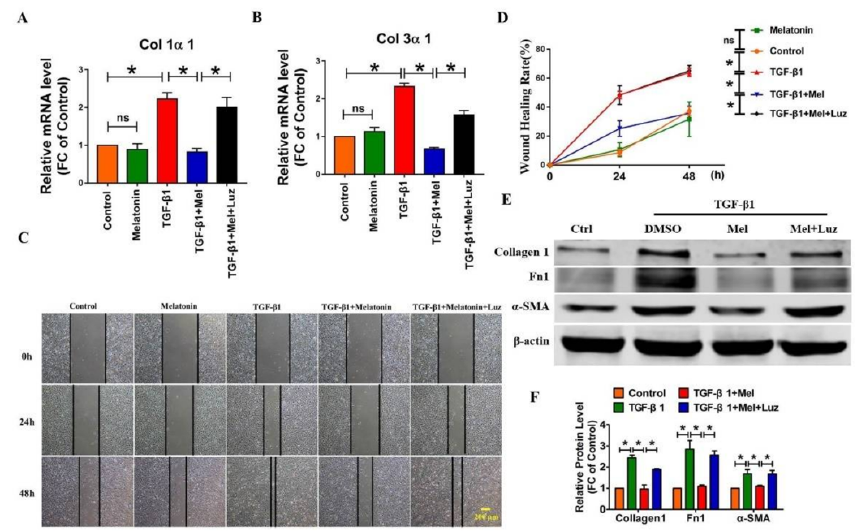
Figure 2. Identification of melatonin receptor as a functional target in melatonin-mediated fibrosis. mRNA expression of Col 1 α 1 ( A ) and Col 3 α 1 ( B ) was obtained with qRT-PCR. β -Actin was used as the internal control. ( C , D ) Wound healing assay demonstrated that luzindole abolished the TGF- β 1-induced cell migration and the Western blot ( E , F ) analysis of fibrosis-related proteins illustrated that luzindole blocked the inhibitory effect of melatonin in TGF- β 1-induced fibrogenesis. β -Actin served as the loading control. Values are the mean ± SEM of five independent experiments. ns: not significant; * p < 0.05.